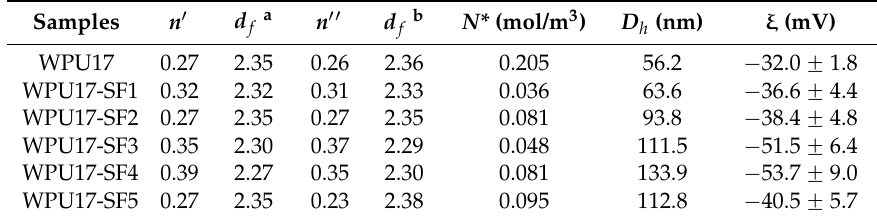
Table 2. The Relaxation Exponent n 1 and n 11 at the Gel Point, the effective concentration elastic chain ( N *), Particle Size, and Zeta Potential of the WPU17 and WPU17-SF Dispersions. Samples n